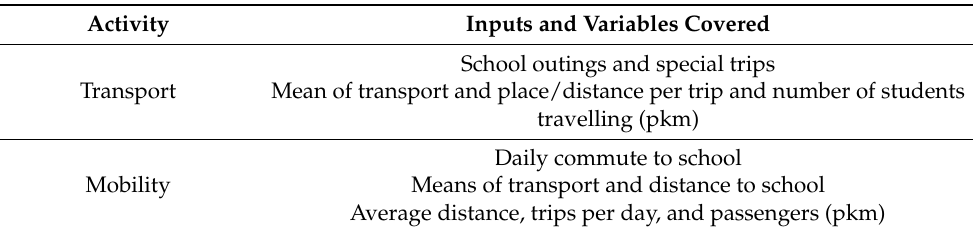
Table 4. Activities included in Subsystem 3 (Mobility and Transport, M&T).